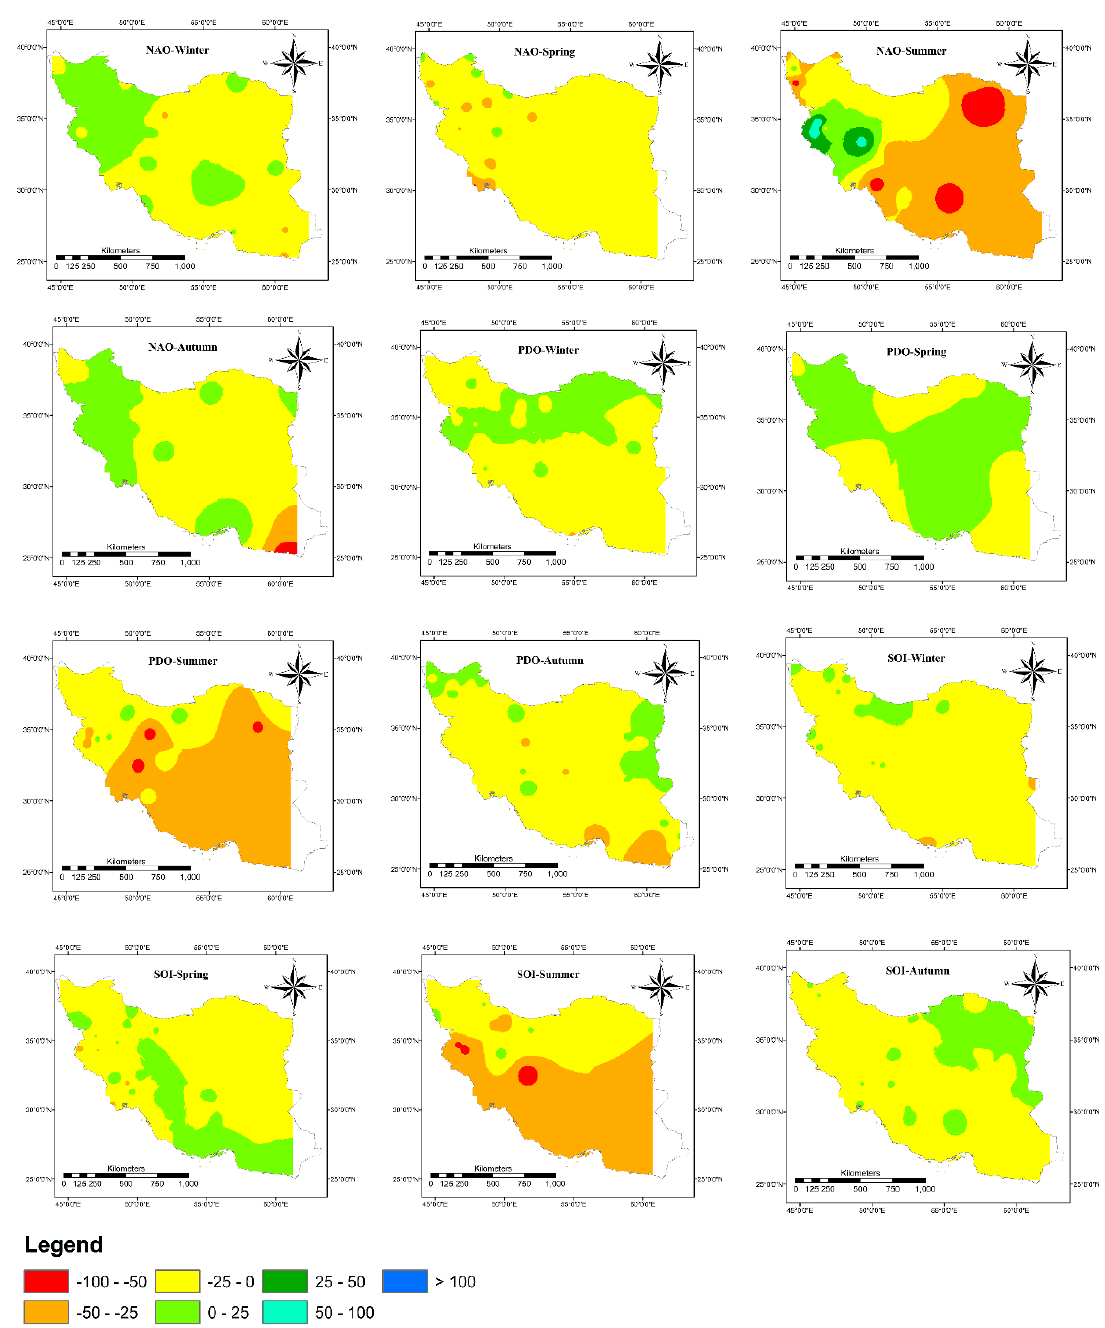
Figure 8. Total change in precipitation due to the effect of SOI, NAO, and PDO in the range of − 1 < x < 1, where x denotes the SOI, NAO and PDO value.